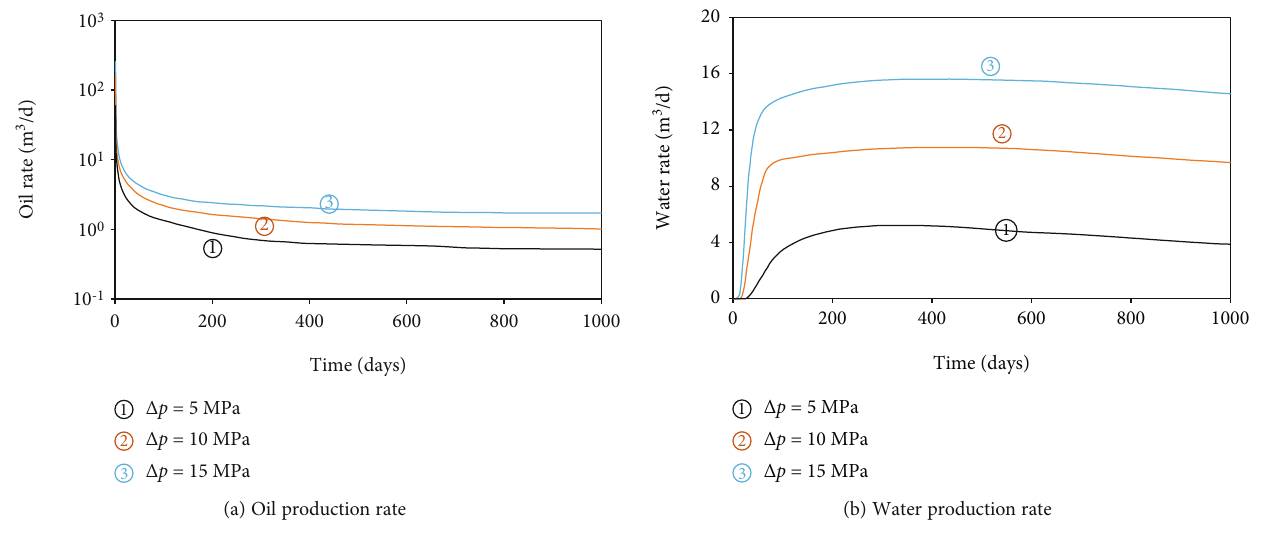
Figure 12: E ff ect of the wellbore pressure drop on oil and water production rates.